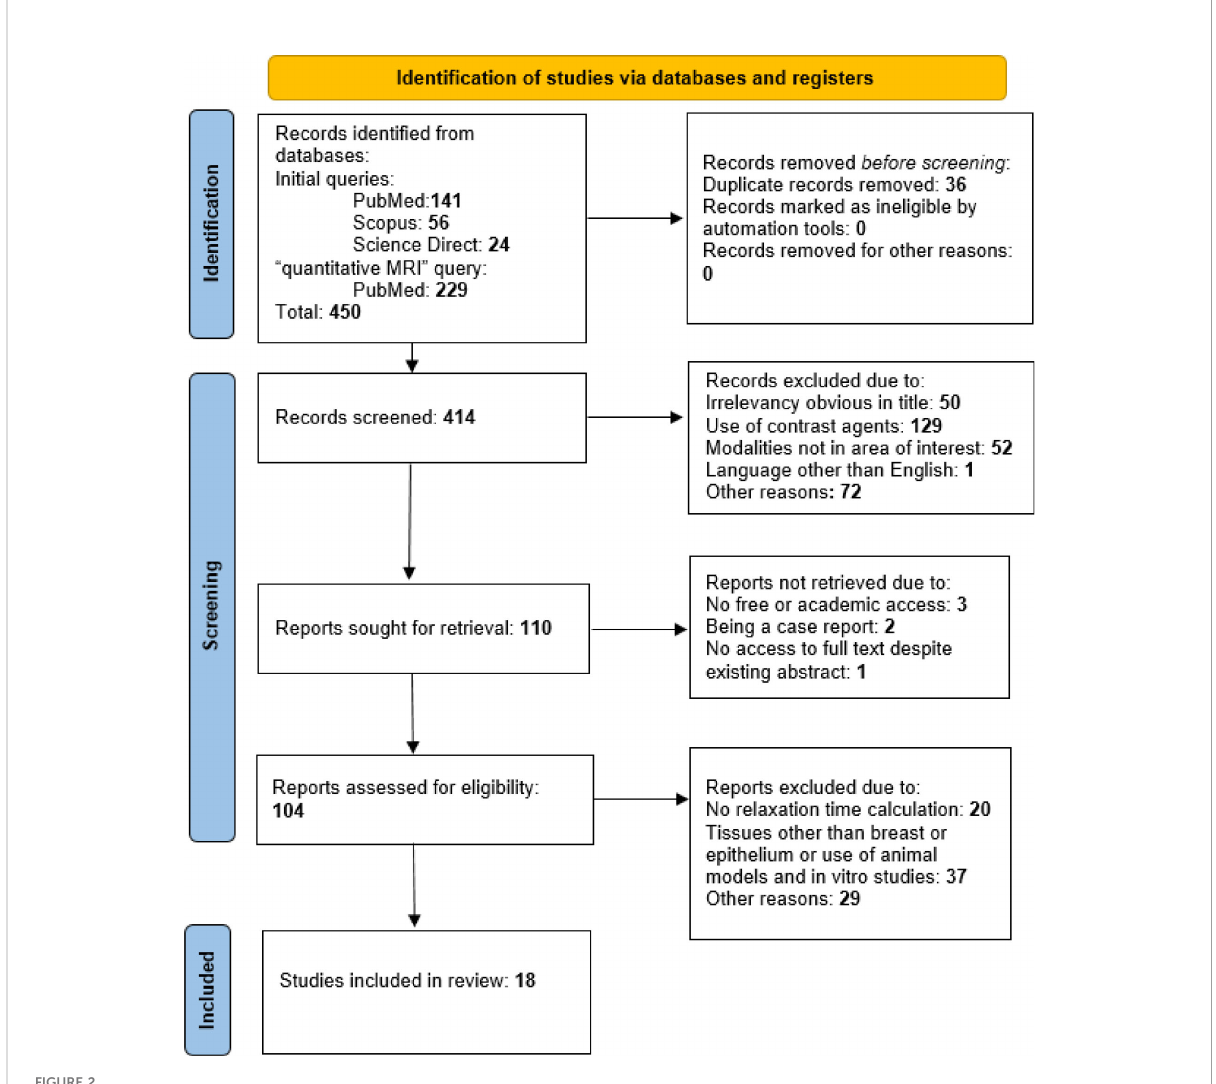
FIGURE 2 The review process is summarized on a PRISMA